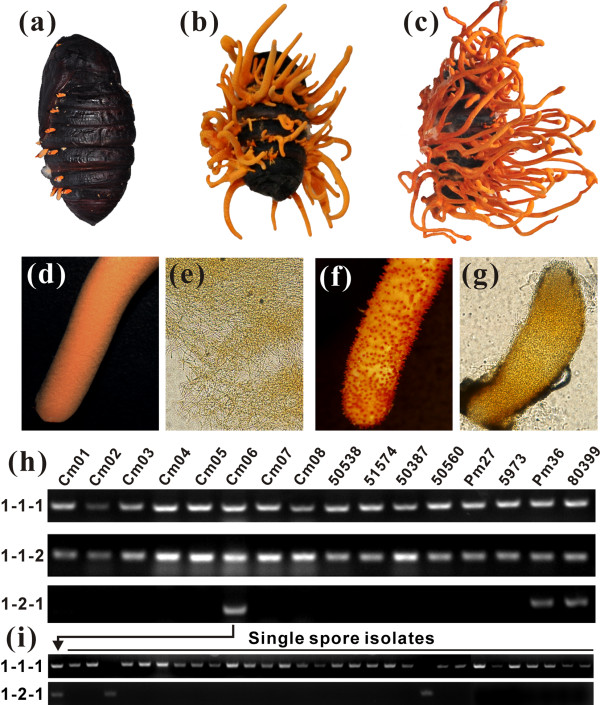
Fruiting body development, sexuality and mating-type analysis. (a-c) Chinese Tussah silkmoth pupae were inoculated with conidia from the C. militaris Cm01 strain and incubated for 14 days (a), 29 days (b) and 59 days (c) to produce nascent, mid-term and developmentally mature fruiting bodies. (d-g) The mature fruiting bodies of the Cm01 strain do not produce perithecia (d, e) but those of strain Cm06 are completely covered with protruded perithecia (f, g). (h) PCR examination of different strains (numbers labeled on the top) showed that strains Cm06, Pm36 and 80399 contain the MAT1-1-1, MAT1-1-2 and MAT1-2-1 genes while Cm01 and other strains lack the MAT1-2-1 gene. (i) PCR examination of 30 randomly selected single spore isolates from the hybrid strain Cm06 showed that only 2 out of 30 isolates contain the MAT1-2-1 gene.